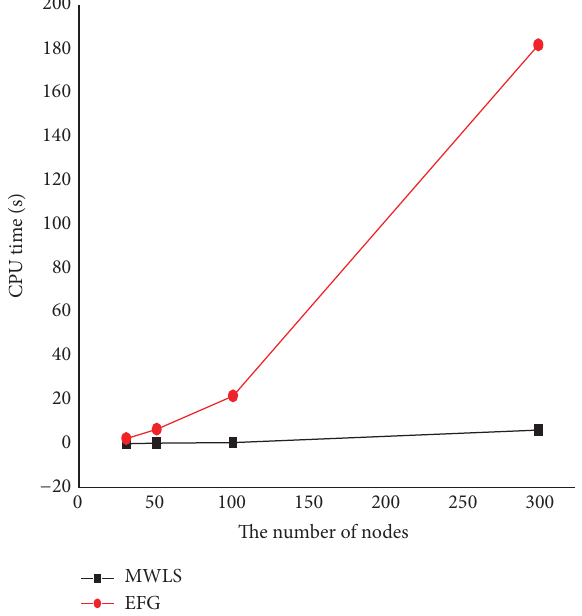
Figure 2: Variation of computational time with number of nodes.